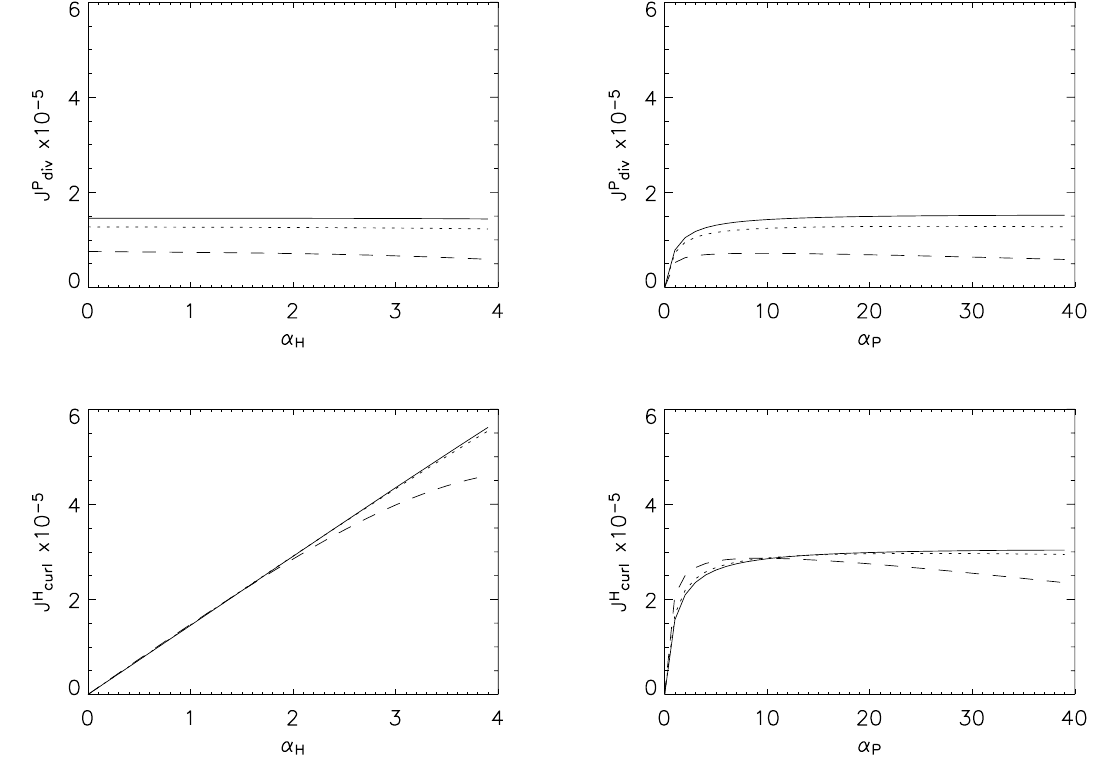
Fig. 6. The magnitude of the ionospheric current densities for the electrostatic approximation where V a = 1 × 10 6 ms − 1 , k x =0, k y =1/d and d=100km and f=2mHz. The variation with α P has α H =2 and the variation with α H has 6 P = 10S. The dip angle of B 0 is 90 ◦ (solid), 60 ◦ (dotted) and 30 ◦ (dashed)